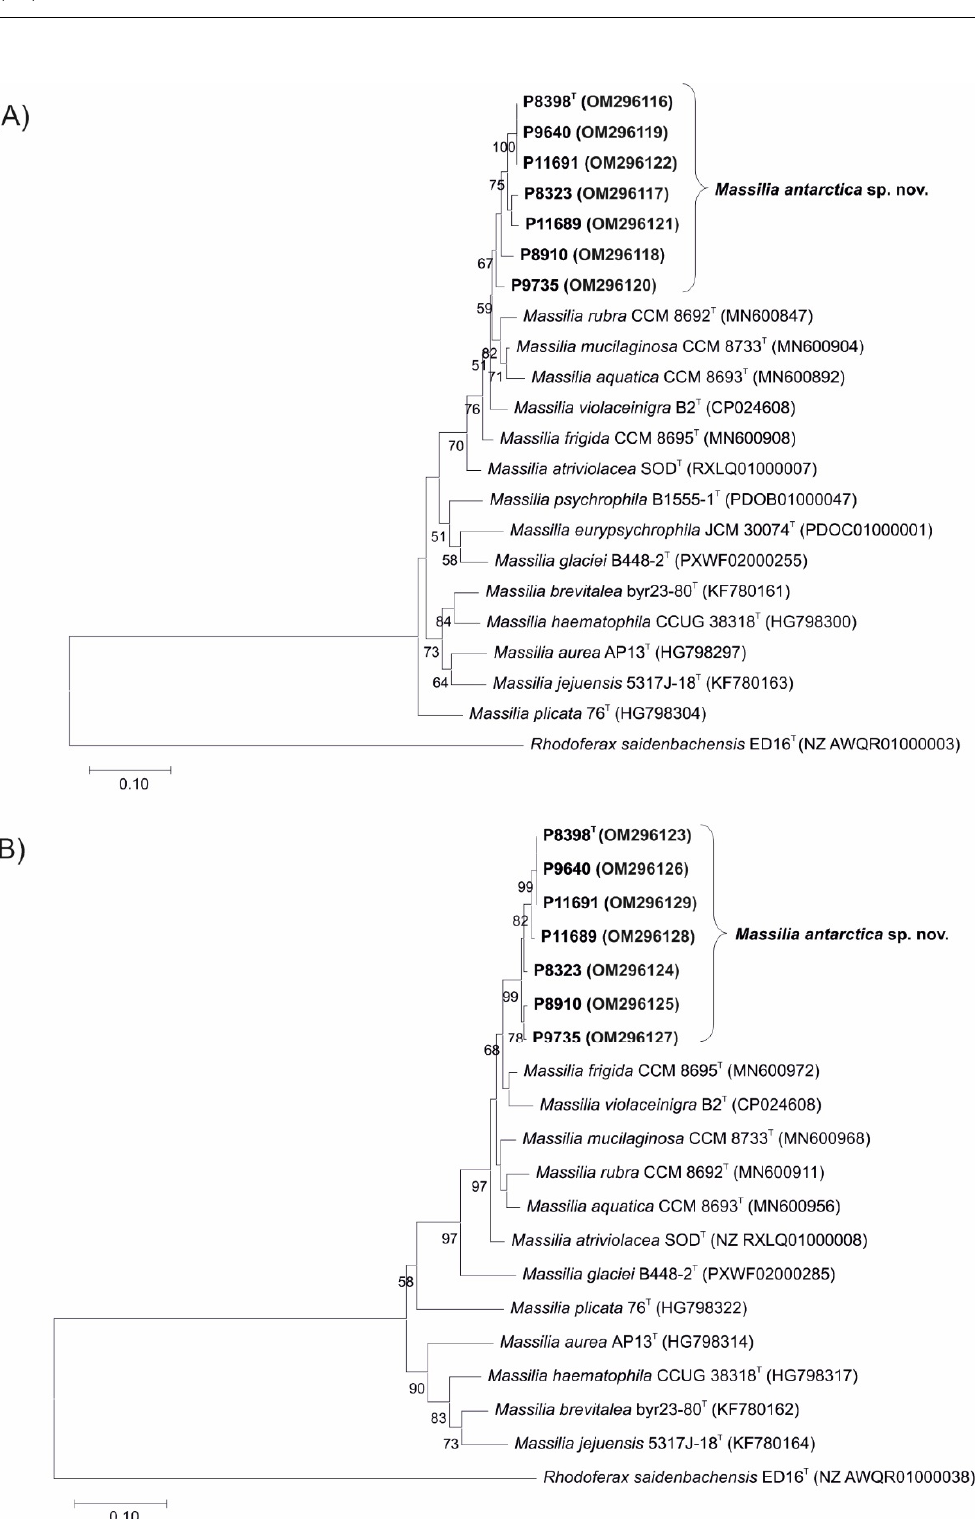
Figure 1. Phylogenetic maximum likelihood trees based on ( A ) gyr B and ( B ) lep A gene analyses showing phylogenetic positions of M. antarctica sp. nov. isolates and closely related Massilia spp.